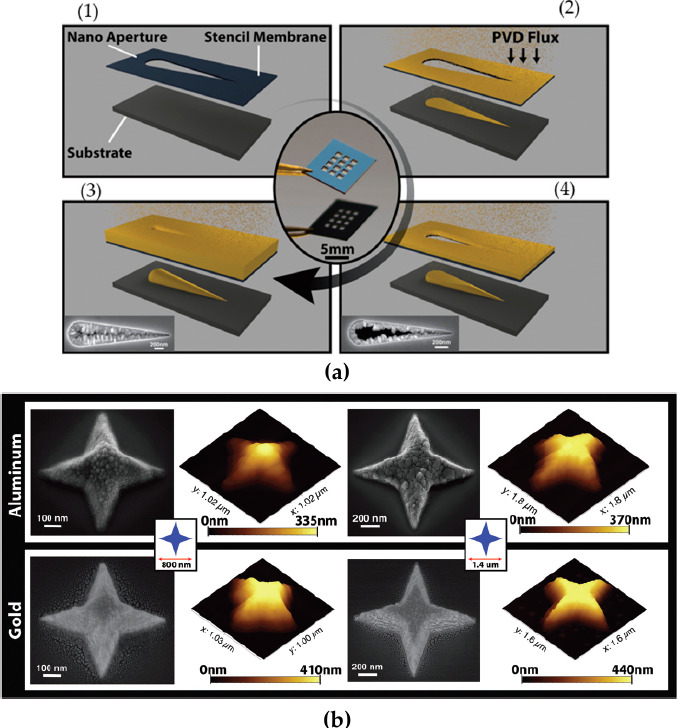
Figure 4. ( a ) Closing effect in stencil lithography: (1) assembly of the stencil mask on a substrate; (2) metal deposition through the open aperture; (3) partial clogging of the stencil mask; (4) full closure of the stencil mask. Reproduced from [64] with permission of The Royal Society of Chemistry. ( b ) Four-pointed star-shape nanostructures with 3D topography. Top and bottom rows represent both the SEM images and the atomic-force microscopy (AFM) topography of the Al and Au nanostructures, respectively. The nanostructure is shown in two different scales: the smaller pattern (left) with 800 nm and the bigger pattern (right) with 1.4 µm in total width. Reproduced from [64] with permission of The Royal Society of Chemistry.